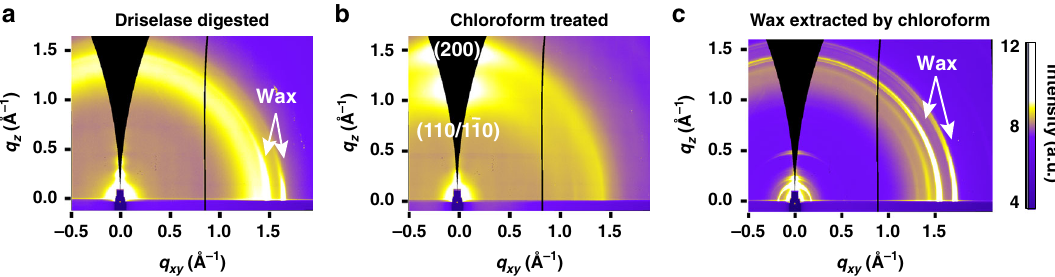
–0.5 0.0 0.5 1.0 1.5